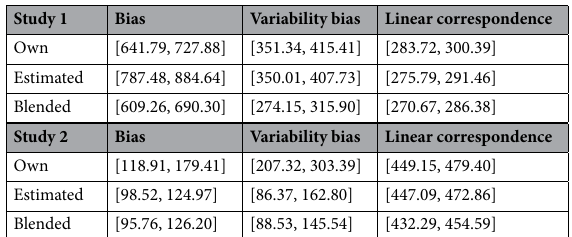
Table 2. Results of the MSE decomposition (95% CI; in Study 1, all types of opinions did not follow a normal distribution, Kolmogorov–Smirnov test: ps < 0.001). It can be observed that the Blended opinion had a smaller variability bias than the Own opinion across the two studies. In addition, in Study 1, the Blended opinion had a smaller bias and variability bias than the Estimated